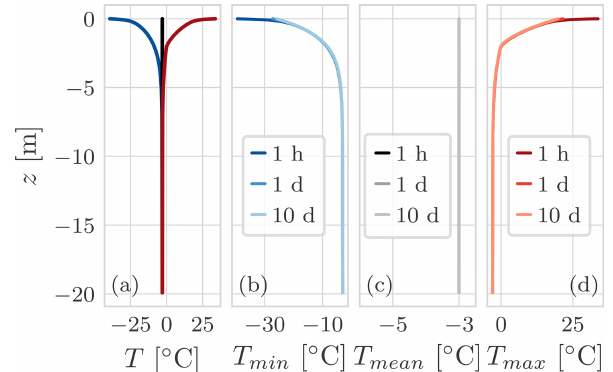
Figure G4. Temperature profile envelope considering λ w = λ i . (a) The minimum, mean, and maximum temperature profile for the hourly simulation. Panels (b) , (c) , and (d) show the comparison of the minimum, mean, and maximum temperature profile respec- tively for the three simulations: with an hourly surface temperature boundary condition and (cid:49)t = 1h, with a daily surface temperature boundary condition and (cid:49)t = 1d, and with a 10d surface temper- ature boundary condition and (cid:49)t = 10d. All three simulations last 100 years. Because λ w = λ i , the mean temperature, panel (c) , is constant throughout the soil column, and it is not possible to appre- ciate the thermal offset. The mean temperature is very close to the initial temperature profile; the maximum error is 0 . 003 ◦